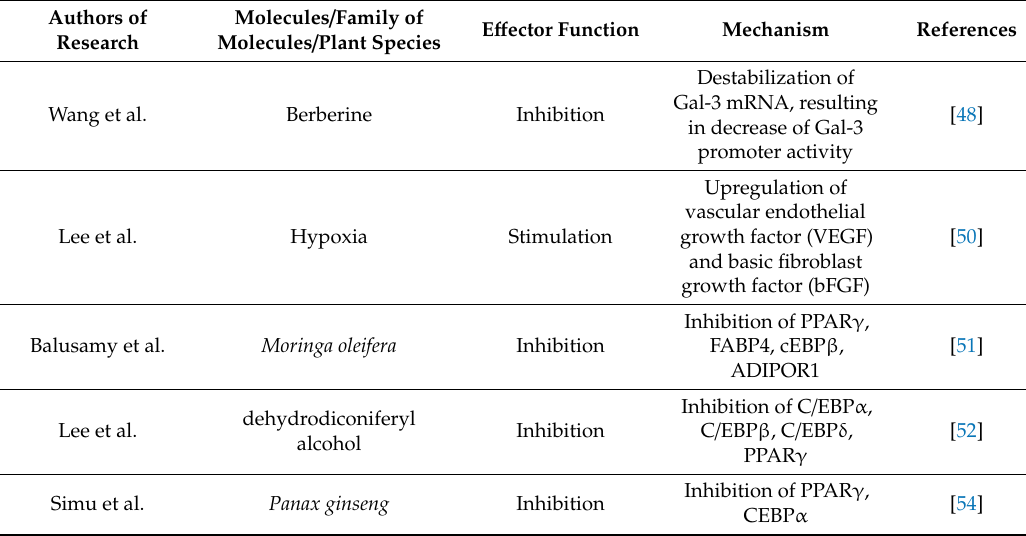
Table 2. Functional significance of including varying impact of external herbal e ff ectors on adipocyte proliferation. The function of a particular e ff ector, such as inhibition or stimulation is determined and supplemented accordingly by the following mechanisms and signaling